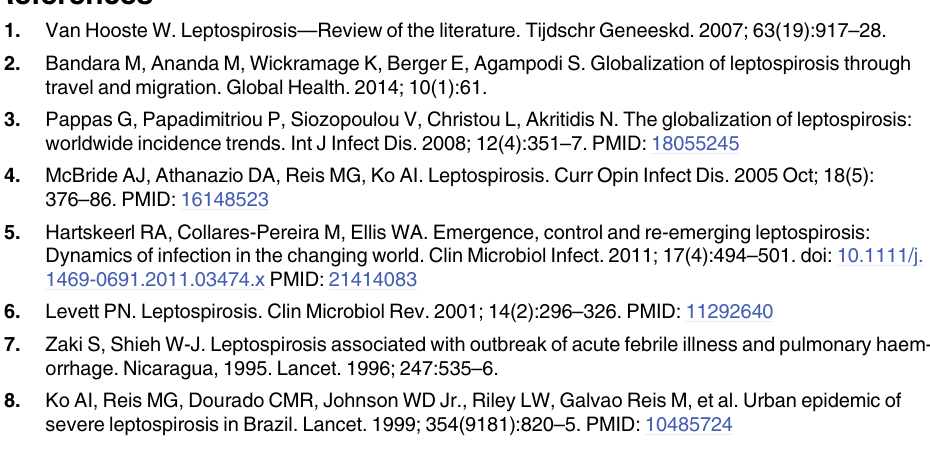
S1 Table. Inclusion and exclusion criteria. S2 Table. Criteria for assessing bias within studies. S3 Table. Articles excluded due to the full text not being available or the article not being translated. S4 Table. Reasons for exclusion of full articles. S5 Table. Bias within each patient series. S6 Table. Assessment of bias within studies. S7 Table. Median mortality in patient series according to study